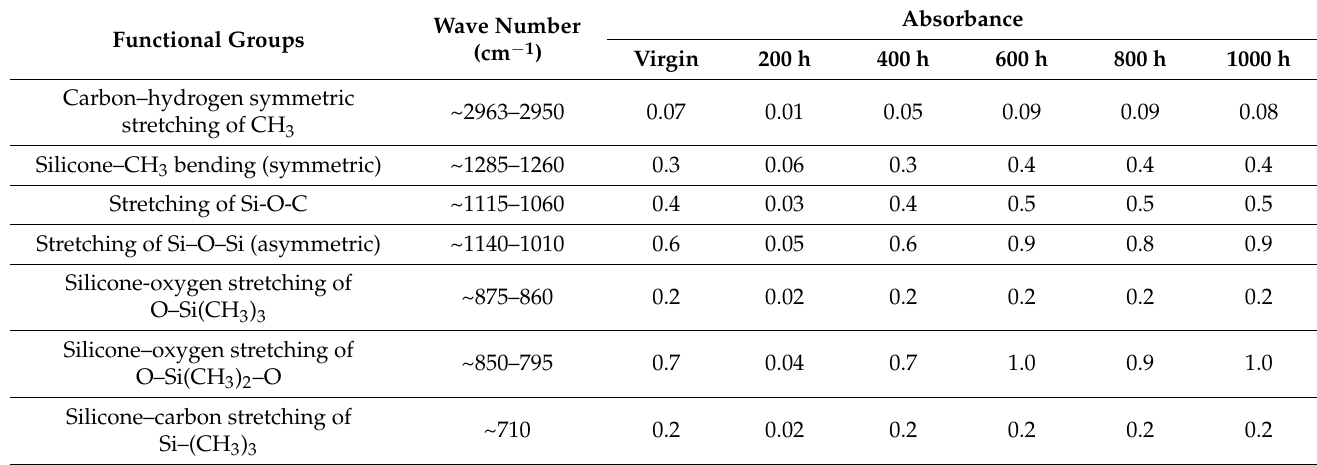
Table 4. Peak absorption of major groups in SMC 15 from virgin to 1000 h.